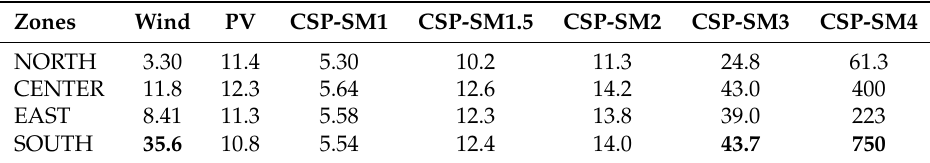
Table 4. Minimum-variance ratios (10 3 MW) given by